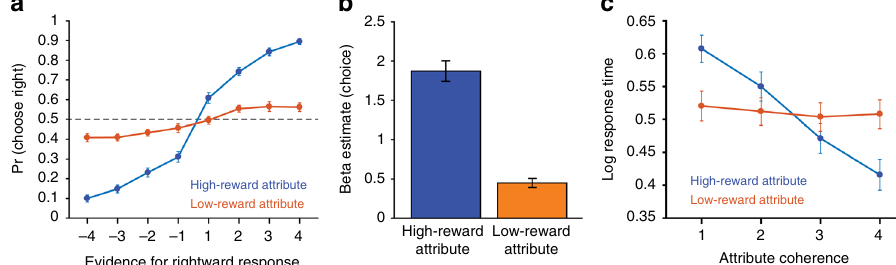
Fig. 2 Behavioral sensitivity to attribute evidence and rewards. During Epochs 2 and 3, responses were highly sensitive to both the amount of evidence and the relative reward for the two attributes. a A psychometric curve shows that participants were much more likely to select a response the more evidence it provided for the high-reward attribute. b Regression coef fi cients for the in fl uence of high- and low-reward coherence on choice. While high-reward attribute coherence exerted the strongest in fl uence on responses, participants were still sensitive to the evidence supporting the low-reward attribute. c Consistent with psychometric patterns in a and b , RTs were also more sensitive to the (unsigned) coherence of the high-reward attribute relative to the low-reward attribute. See also Supplementary Fig. 1. Error bars re fl ect